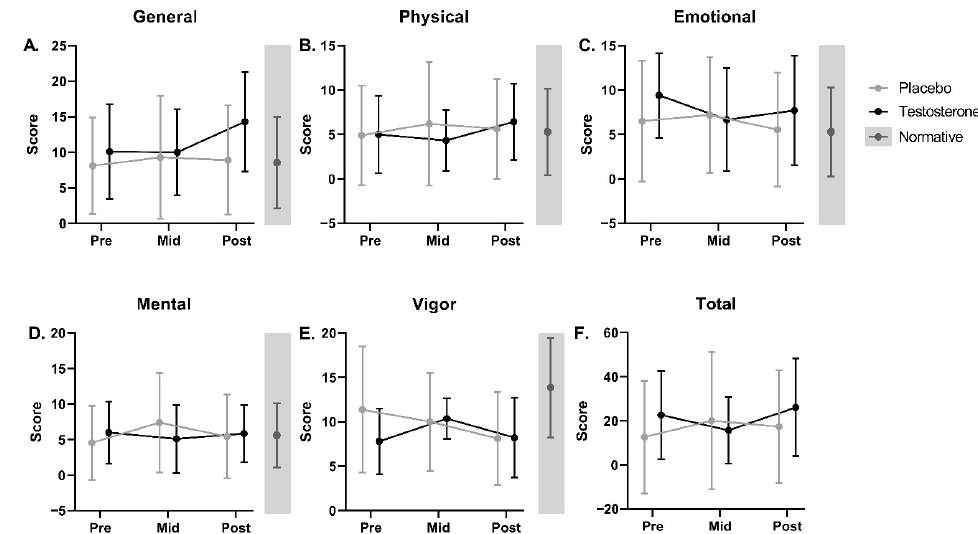
Figure 5. Multidimensional Fatigue Symptom Inventory—Short Form (MFSI) subscale and total scores at pre, mid, and post for cancer patients receiving testosterone or placebo. Average ( ± SD) scores for ( A ) General Fatigue, ( B ) Physical Fatigue, ( C ) Emotional Fatigue, ( D ) Mental Fatigue, and ( E ) Vigor subscales, as well as ( F ) Total score. Average (±SD) normative scores [62], as available, are displayed in gray sidebars to the right of each graph. There were no significant differences between groups or in scores over time for either group. Higher scores on presented questionnaires are undesirable and indicate greater symptom severity, with the exception of Vigor ( E ), for which lower scores are undesirable and indicate greater symptom severity.